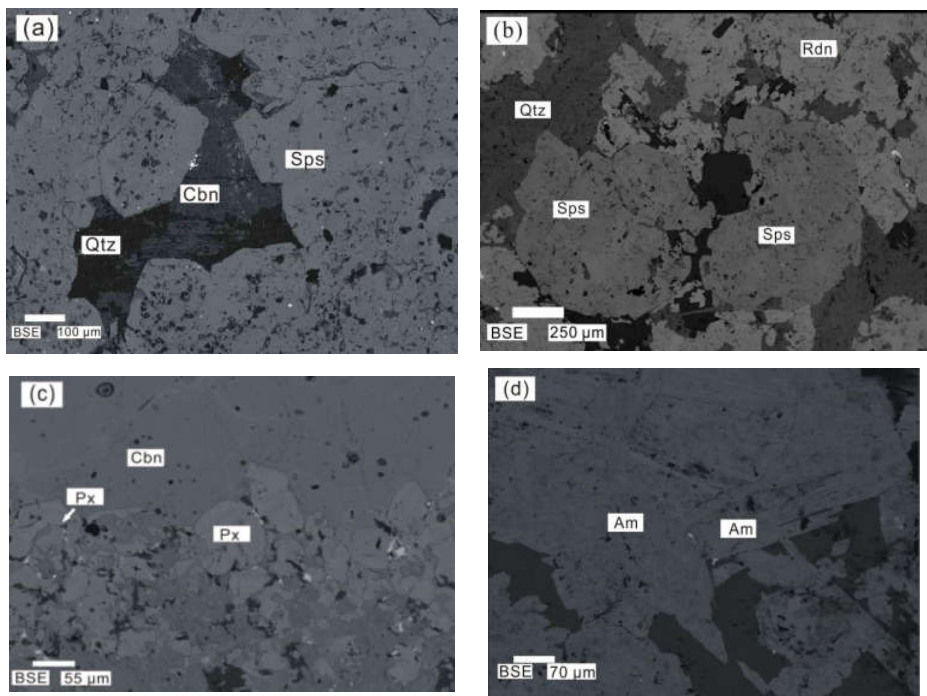
Figure 4. BSE images of JingFenCui: ( a ) carbonate (Cbn), quartz (Qtz), and spessartine (Sps) in Zone B; ( b ) rhodonite (Rdn), quartz, and spessartine in Zone D; ( c ) carbonate (Cbn) and pyroxene (Px) in Zone C—Pyroxene is idiomorphic-hypidiomorphic-granular with metasomatic-dissolved texture; ( d ) the amphibole (Am) is long-columnar, needle-columnar in Zone C. The dissolved traces can be seen on the surface of